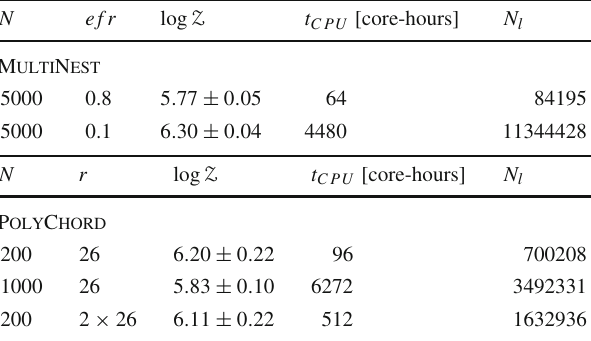
Table 2 An example of basic quantitative comparison of the relative performance between PolyChord and MultiNest for the 26 param- eters pNMSSM. Here N , ef r , r , log Z , t CPU and N l are respectively the nested sampling number live points, MultiNest algorithm tuning parameter, PolyChord tuning parameter ( n repeats ), the logarithm of the Bayesian factor obtained in a run, the CPU core-hours taken and the number of likelihood calculations done before finishing a